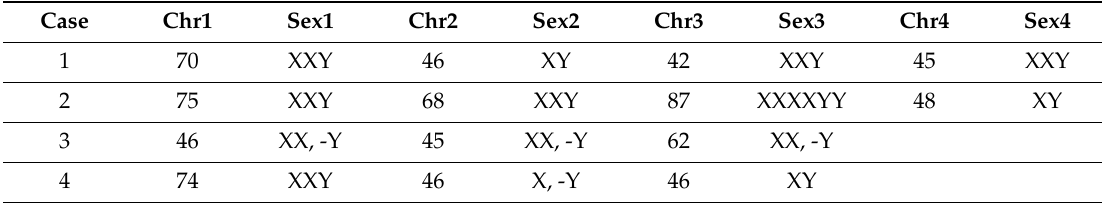
Table 1. Some examples of the polyclonal karyotypes (numbered in columns) from male renal carcinoma with near-triploid XXY, near-diploid, and near- tetraploid clones, extracted from the Mitelman karyotype database. (Chr—modal chromosome number, Sex—sex chromosome